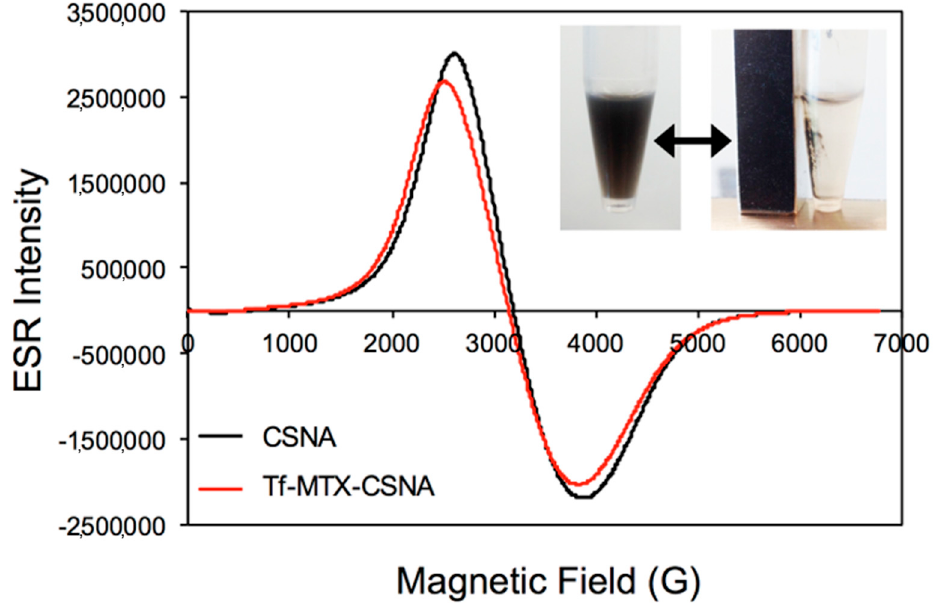
Figure 5. ESR-Magnetic characterization of CSNA and Tf-MTX-CSNAs, showing their outstanding ferromagnetic behavior without the loss of stability. The inset shows how the Tf-MTX-CSNAs can be magnetically guided and/or concentrated using a commercially available conventional magnet.